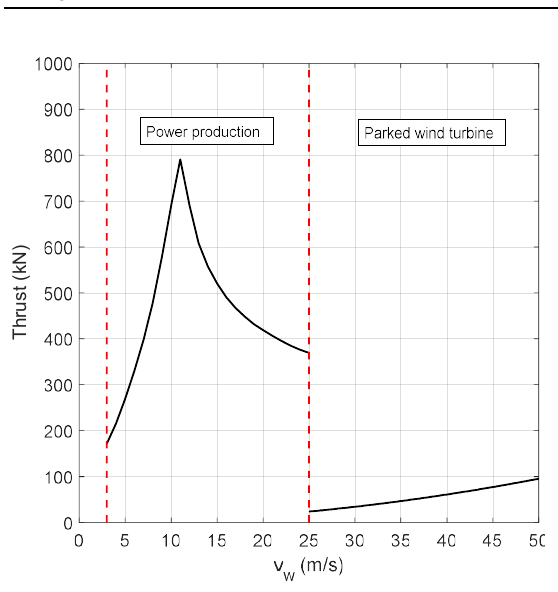
Figure 2. Thrust curve of the NREL 5 MW wind turbine.